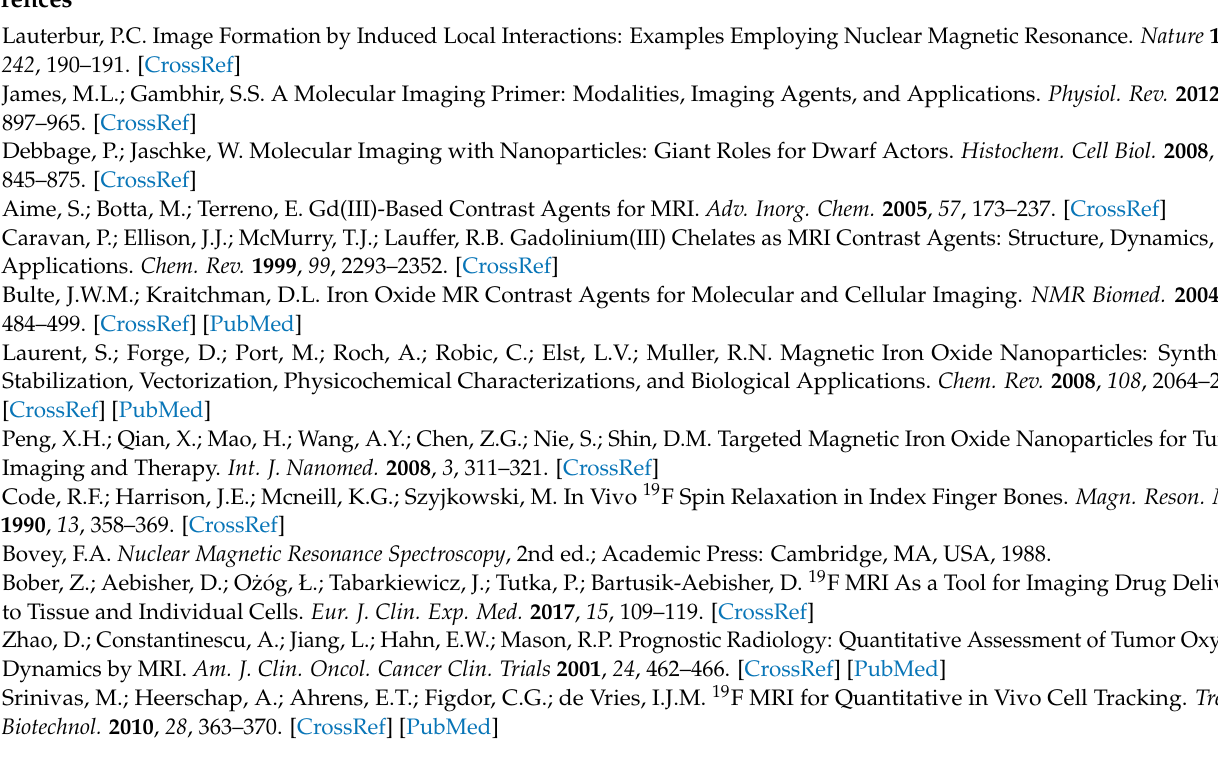
the treatment: Table S1. Results of RAFT-SCVP copolymerization of DMA with VBPC in dioxane at 60 ◦ C at different feed ratios γ =20–40: Table S2. A comparison between DLS and TEM data for HBPs: Table S3. Cbz deprotection using various hydrogen transfer agents: Table S4. List of 19 F T 1 and T